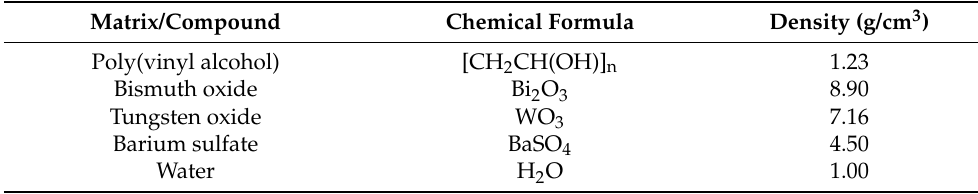
Table 1. Individual densities of PVA, Bi 2 O 3 , WO 3 , BaSO 4 , and water used for the determination of densities for PVA hydrogels